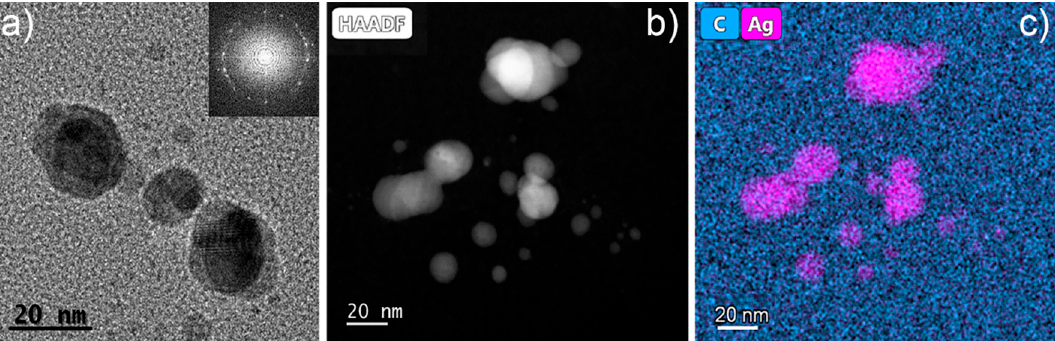
Figure 2. ( a ) HRTEM image of a 3D printed part of the sample 1N. The inset shows the Fast Fourier Transform pattern of the image in ( a ), exhibiting the crystallinity of the nanoparticles; ( b ) HAADF- STEM image of the 3Cl nanocomposite; ( c ) EDX map of the image in ( b ) showing C from the acrylic resin (blue) and Ag from the nanoparticles (pink).